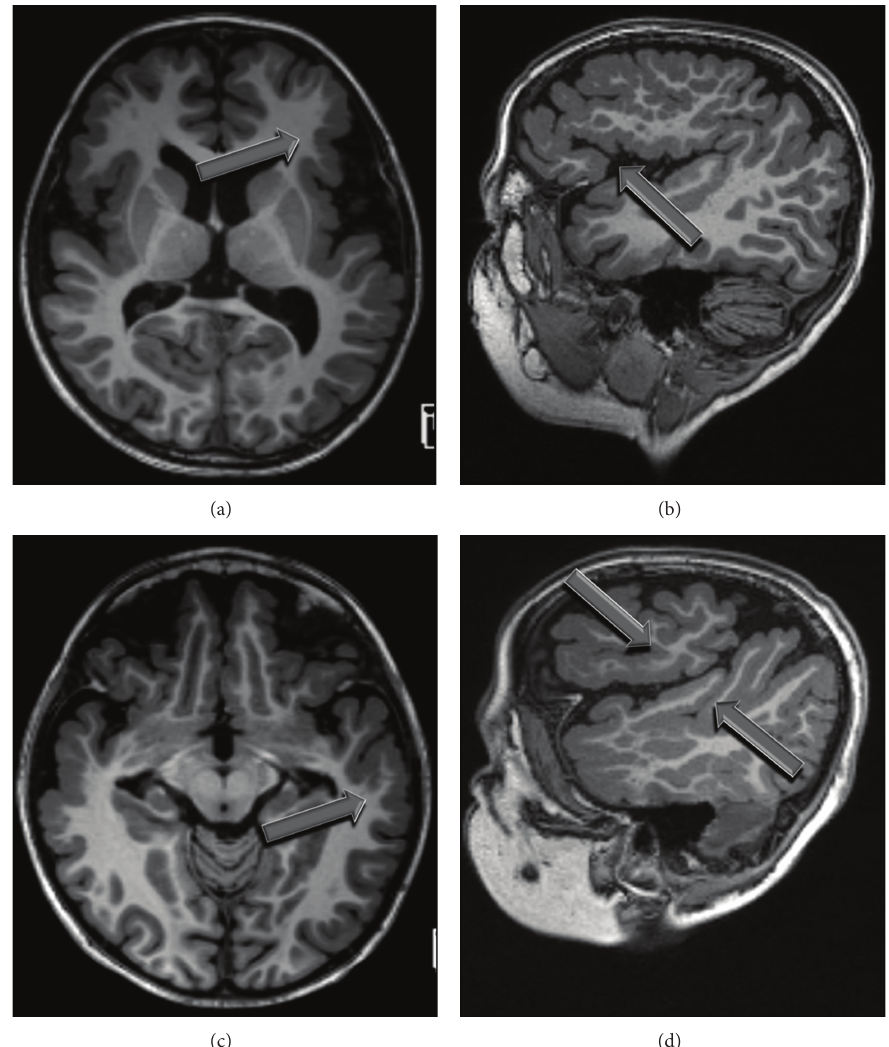
Figure 1: Axial (a) and sagittal (b) MPRAGE images demonstrate polymicrogyria involving the left inferior frontal gyrus. Similarly, involvement of the left posterior perisylvian region can be seen on axial (c) and sagittal (d) MPRAGE images in the same